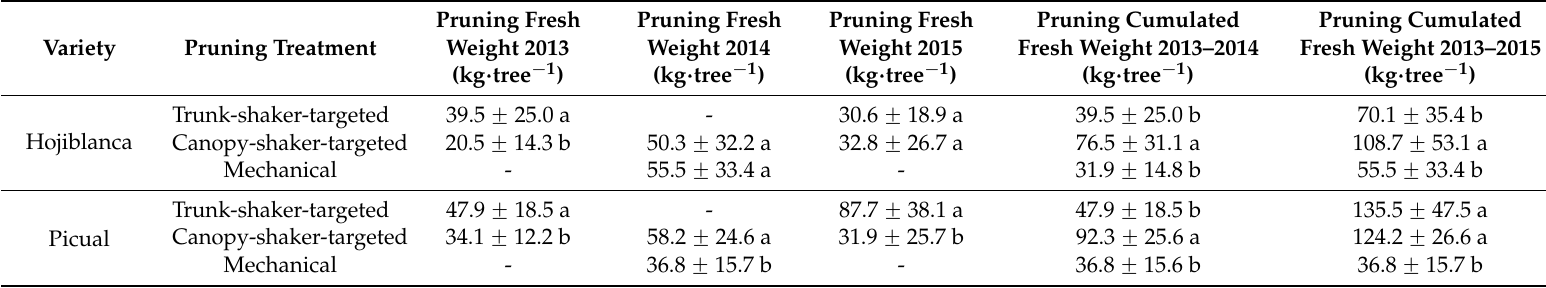
Table 4. Pruning residues removed from the trees for each variety, treatment, and year. Values are mean ˘ standard deviation. Different letters in same columns showed significant differences ( ρ < 0.05) according to Duncan’s test between different pruning treatments and in the same sampling